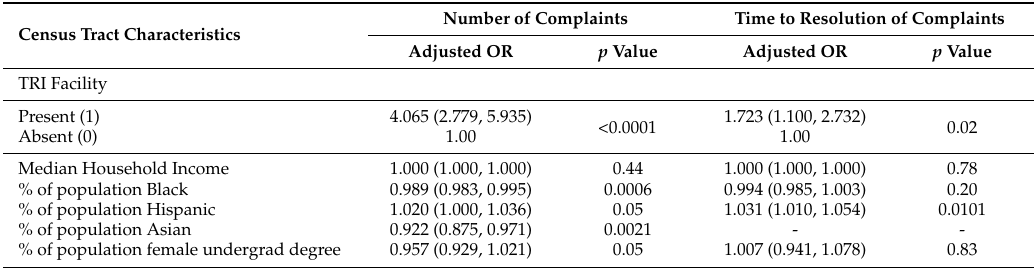
Table 6. Multivariate models explaining complaint